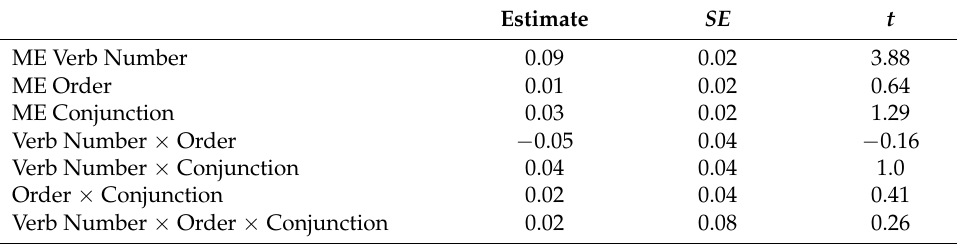
Table 11. Summary of the statistical analyses of participants’ reading times at the critical verb segment, Experiment 3.